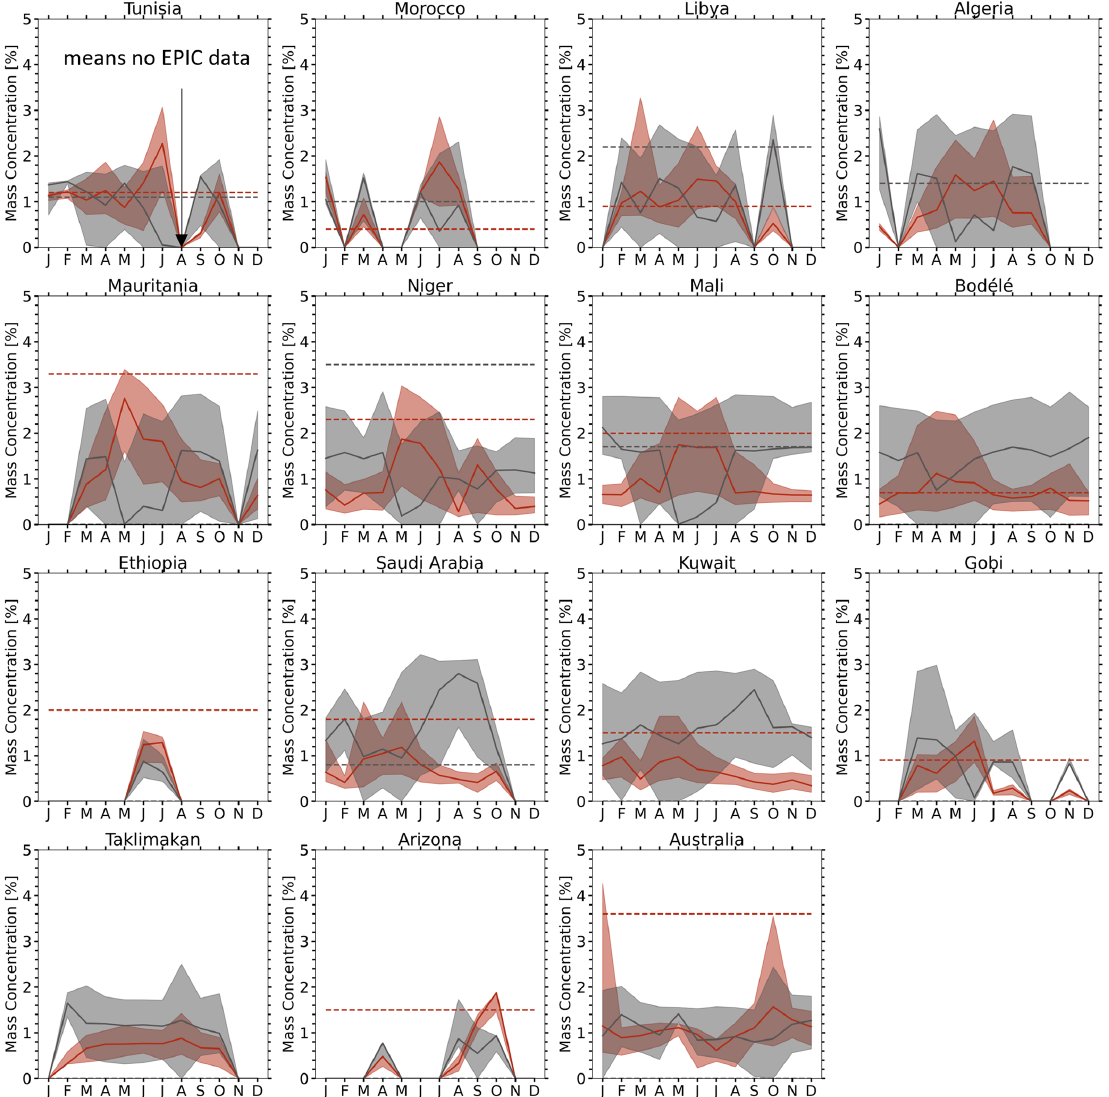
Figure 8. Monthly variations (5th, 50th, and 95th percentiles) of hematite (red shading) and goethite (gray shading) mass concentration (wt%) calculated from MAIAC EPIC at each site for 2018. Solid lines at the centers of shaded areas indicate median values for hematite (red) and goethite (black). Each site represents an area of ± 1 ◦ of MAIAC EPIC data (pixel with AOD > 1.0) except for Australia ( ± 3 ◦ ). Dashed lines indicate hematite (red) and goethite (black) mass concentrations with ± 10% uncertainty (Di Biagio et al., 2019). At the Algeria site, the two dashed lines coincide (Di Biagio et al., 2019). The invisible dashed lines of goethite (dashed black line) at Mauritania, Bodélé, Ethiopia, Kuwait, the Gobi, Arizona, and Australia indicate zero goethite mass concentration. Di Biagio et al. (2019) do not provide data at the Taklimakan site. Monthly variation statistics are additionally presented in Table